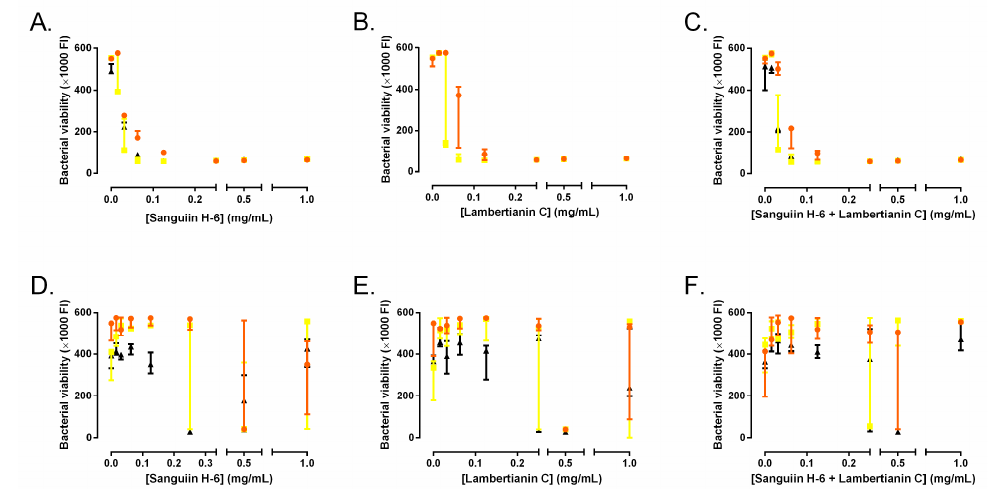
Figure 2. Minimum inhibitory concentrations ( A – C ) and minimal bactericidal concentrations ( D – F ) of sanguiin H-6 ( A , D ) and lambertianin C ( B , E ) and their mixture ( C , F ) against the three methicillin-resistant S. aureus (MRSA) strains: SAP231 (orange circle), MRSA1 (yellow square), and MRSA (black triangle).